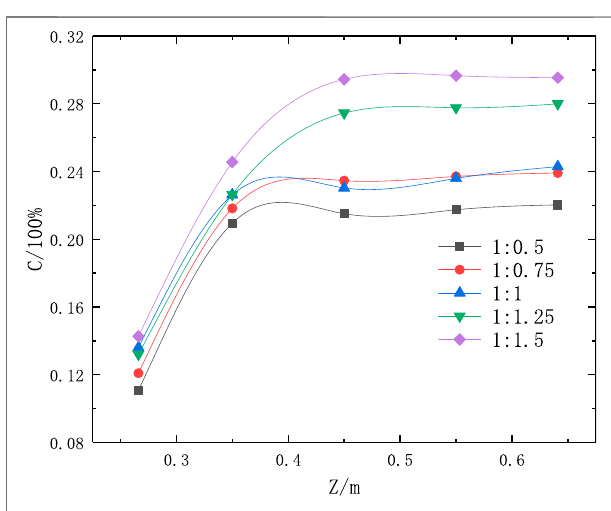
FIGURE 4 | XRD patterns of the pyrolysis products obtained at different temperatures. B-773, D-873K, F-923K, H-973K, J-1023K, L-1123K.